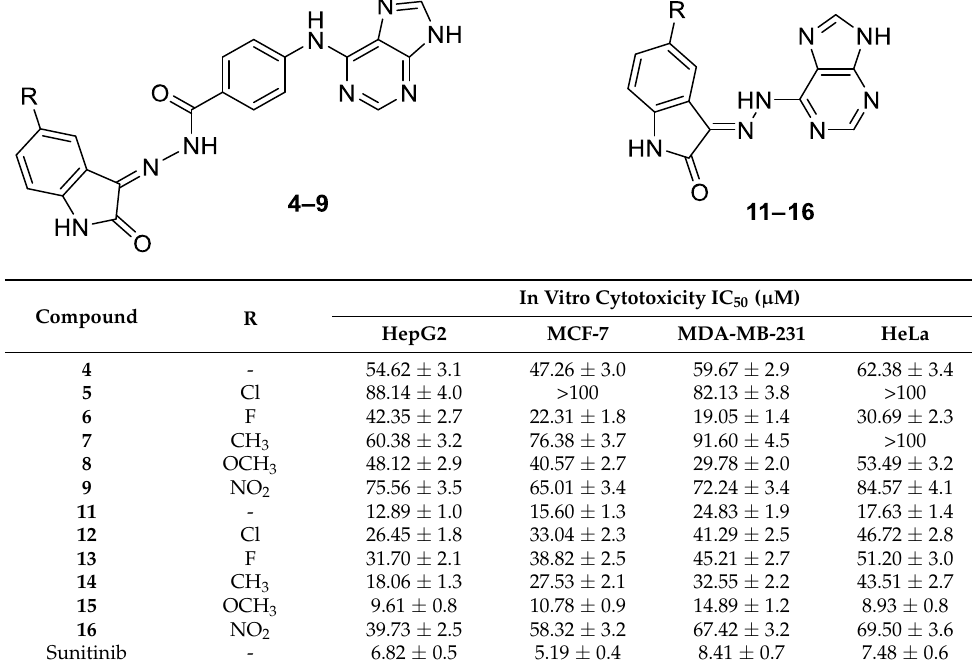
Table 1. Cytotoxicity effect of isatin–purine hybrid compounds 4–16 on HepG2, MCF-7, MDA-MB-231 and HeLa.